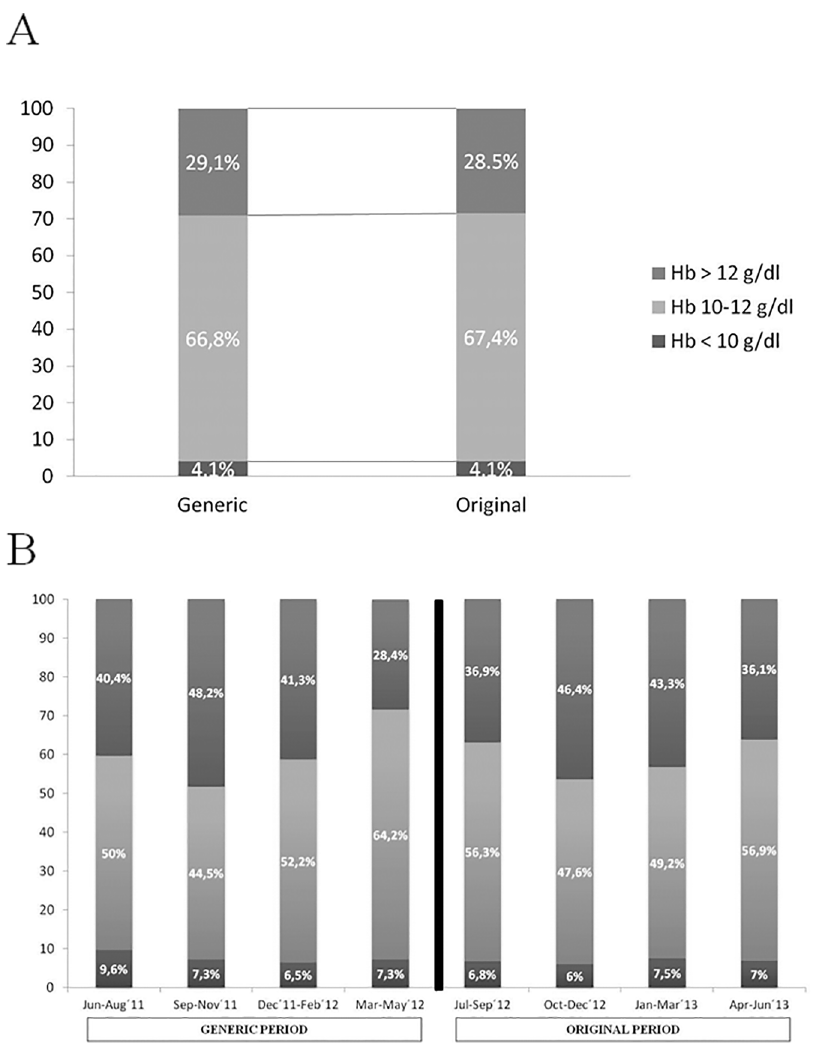
Fig 3. Variability in haemoglobin in each period (3A) and in quarterly